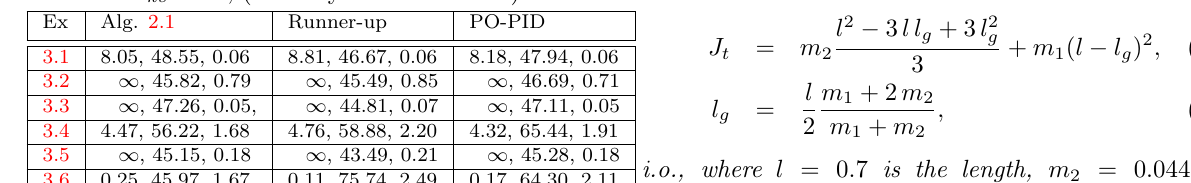
Table 7: Results from Sec. 3.1. Margins organized as ( GM, PM, DM ) for Alg. 2.1 and runner-up, i.e. SIMC, with exception of row 4, K-SIMC, and the optimal controller, PO-PID, for pre- scribed robustness, M st = 1 . 59 or input usage M ks = 50, (i.e. only ‘and’ for col. 6).